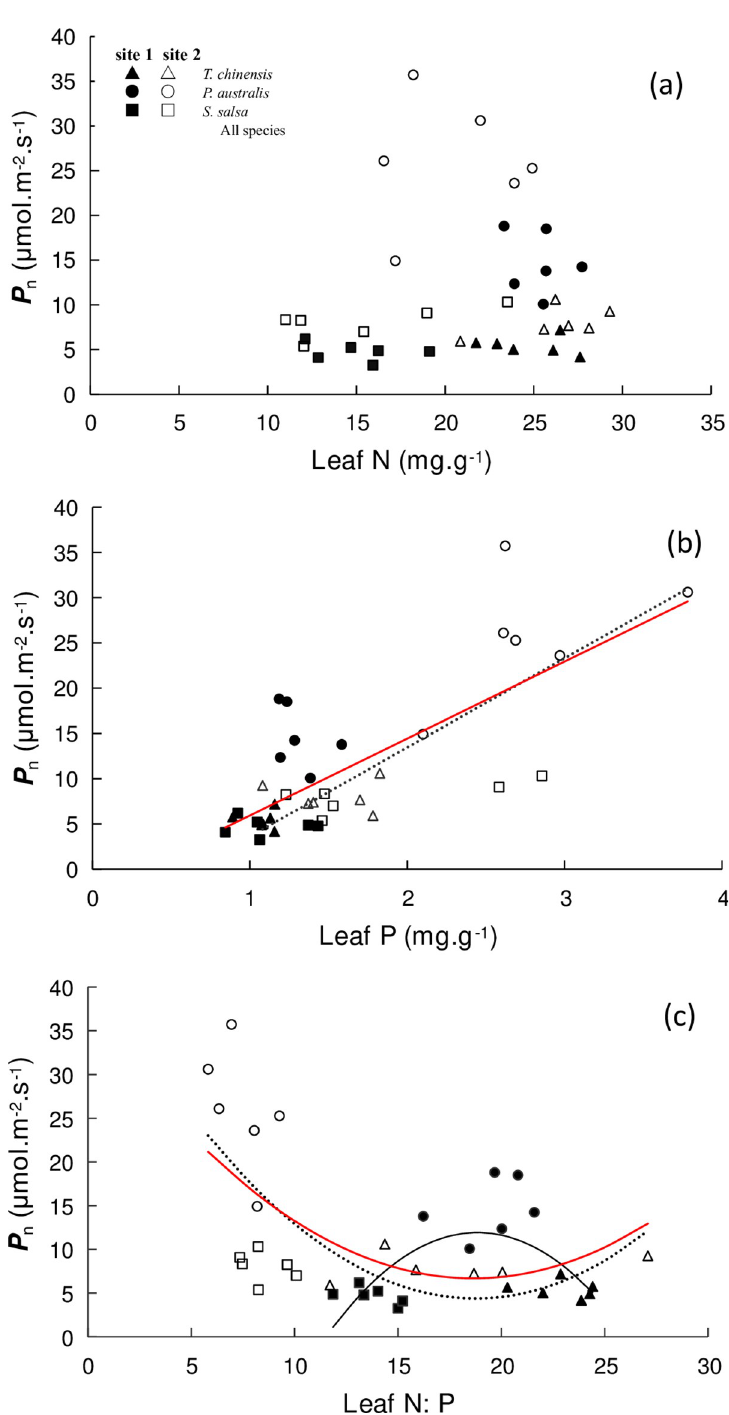
Fig 4. Relationships between leaf nutrient conditions and P n of halophytic plant communities. (a) Leaf N and P n (equations for sites 1 and 2 and all species: P > 0.05). (b) Leaf P and P n (equation for site 1: P = 0.081; equation for site 2: y = 9.8482x − 6.2357, R 2 = 0.589, P < 0.001; equation for all species: y = 8.5006x − 2.5626, R 2 = 0.542, P < 0.001). (c) Leaf N:P and P n (equation for site 1: y = − 0.2213x 2 + 8.3418x − 66.676, R 2 = 0.377, P = 0.029; equation for site 2: y = 0.1112x 2 − 4.1707x + 43.505, R 2 = 0.372, P = 0.031; equation for all species: y = 0.0879x 2 − 3.277x + 37.24, R 2 = 0.306, P = 0.002).